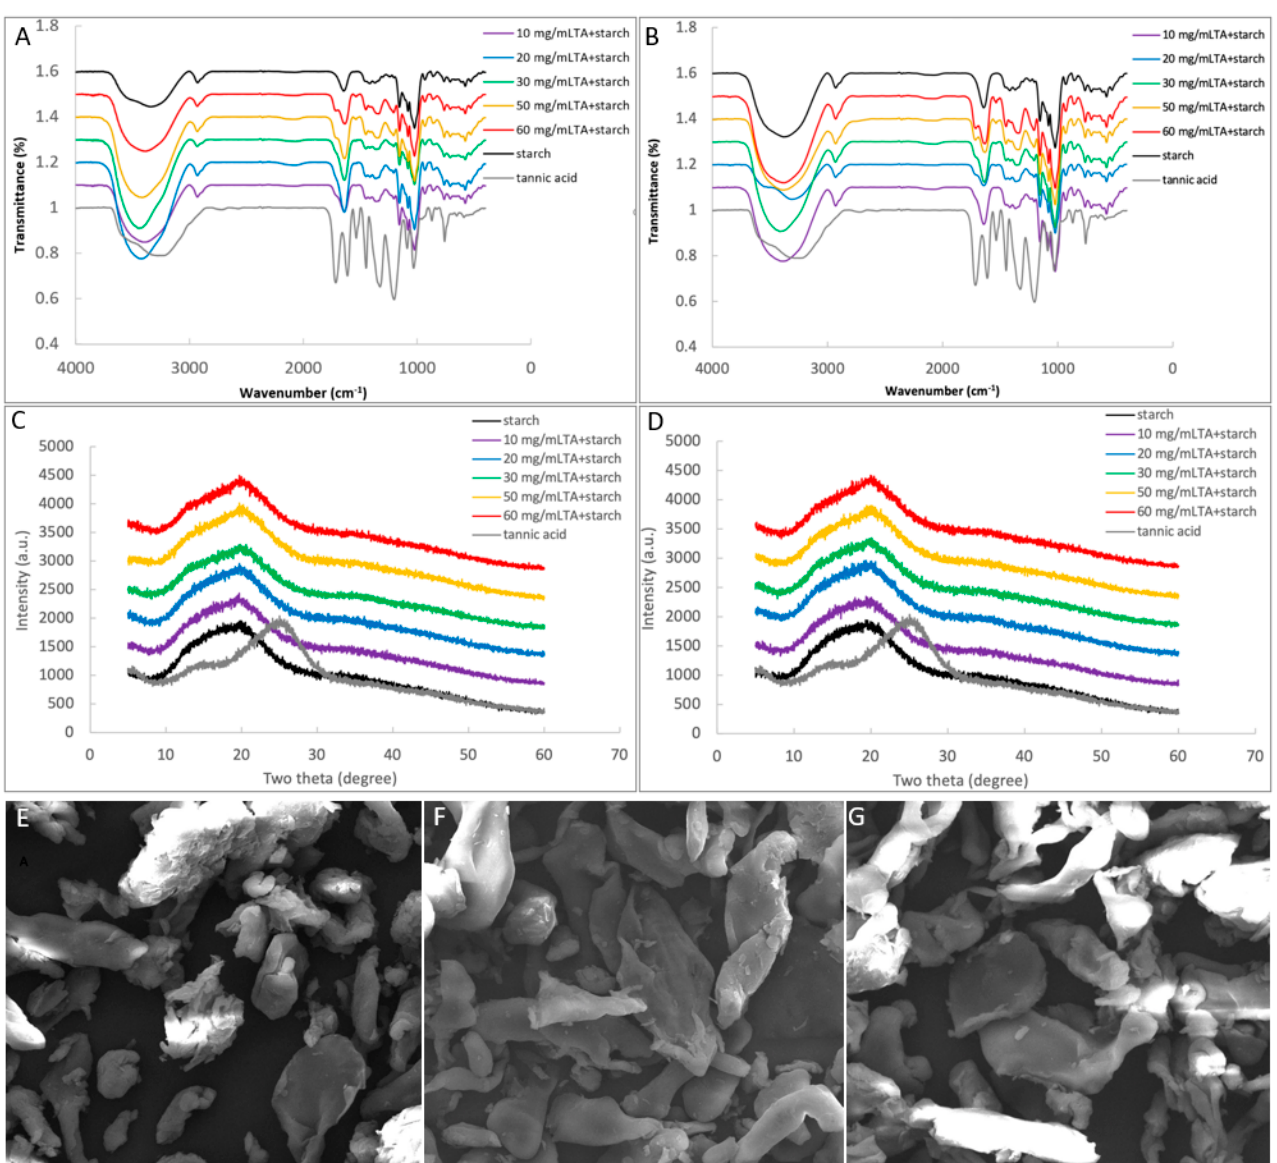
Figure 4. The FTIR spectra of lyophilized gelatinized starch in the absence and presence of TA for mixing TA with pre-gelatinized starch ( A ), and co-gelatinizing TA with starch ( B ). The XRD profiles of lyophilized gelatinized starch in the absence and presence of TA for mixing TA with pre-gelatinized starch ( C ), and co-gelatinizing TA with starch ( D ). The SEM profiles of lyophilized gelatinized starch in the absence ( E ) and presence of TA for mixing TA with pre-gelatinized starch ( F ), and co-gelatinizing TA with starch ( G ) at the magnification of 4000 times.